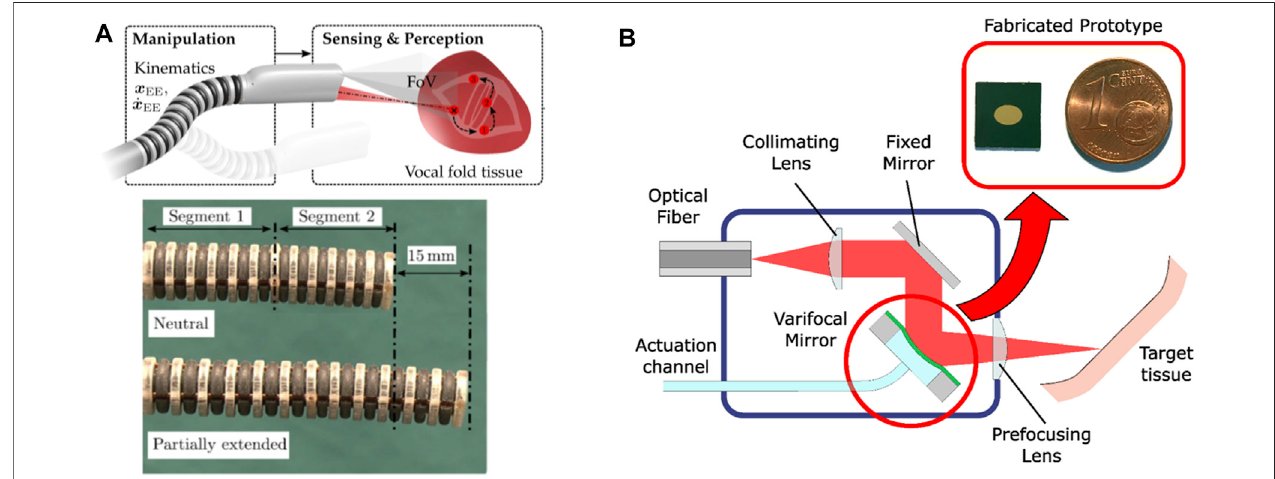
FIGURE6|(A) Extensiblehollowcorecontinuumrobotfornon-contactlasersurgery(Kundratetal.,2019). (B) Highpowerlaserauto-focusingsystembasedona hydraulically actuated MEMS varifocal mirror (Geraldes et al., 2019).